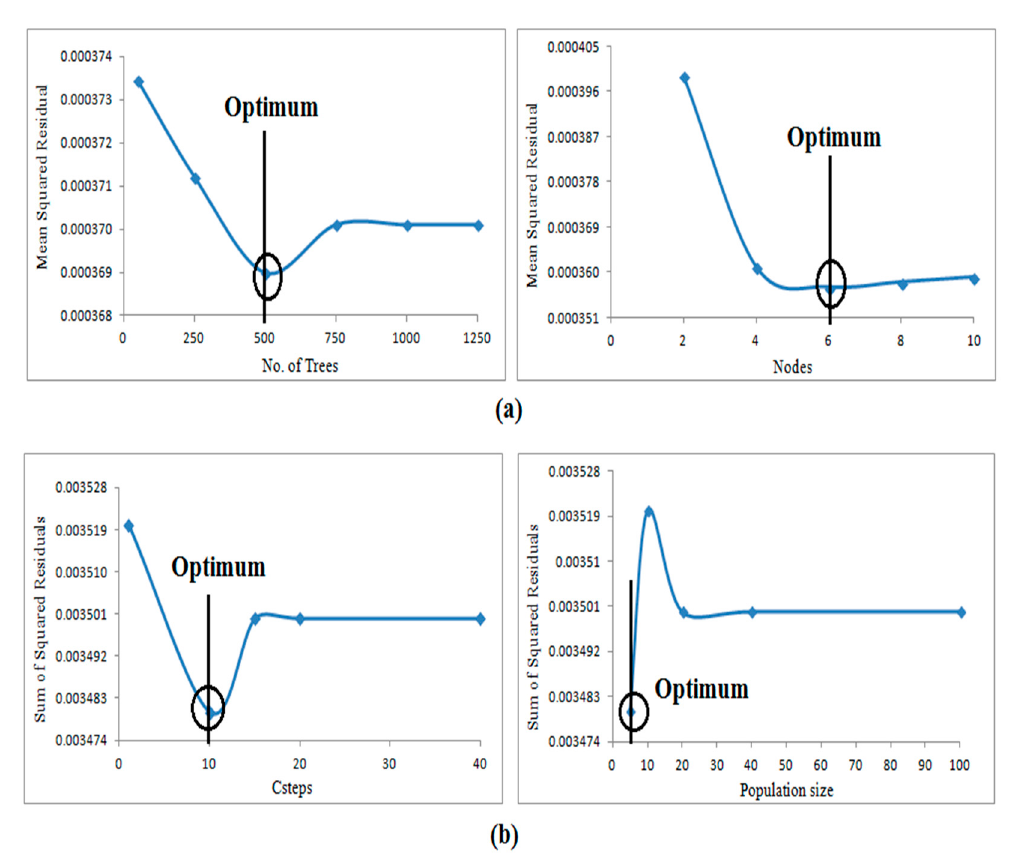
Figure 3. Optimization of ( a ) number of trees and nodes in RFs ( b ) Csteps and population size in GALTS.